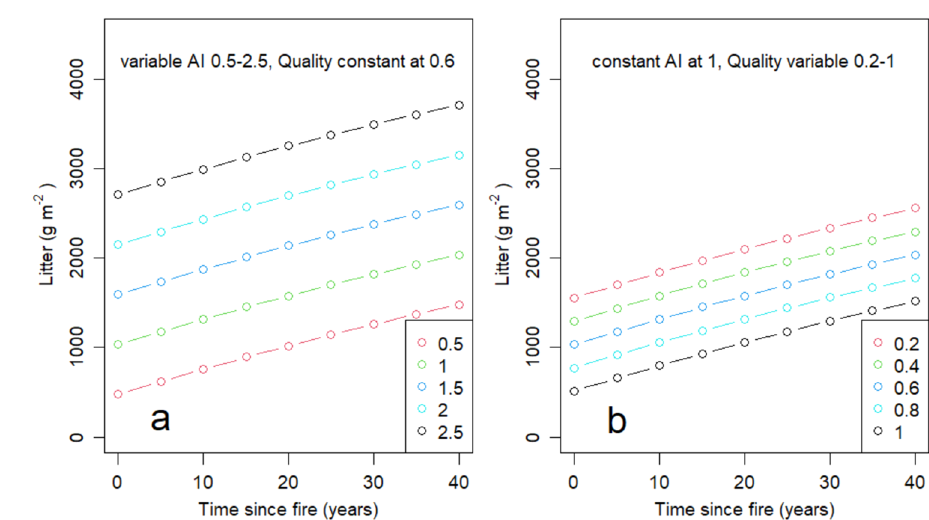
Fig.6|Modelpredictionsoflittermasswithincreasingtime.a Littermasswith fi xedlitterfallquality(Q lf )andarangeofvaluesforaridityindex(AI), b Littermasswith fi xed AI and a range of values of Q lf . Models represent all species from genera Eucalyptus, Corymbia and Angophora .